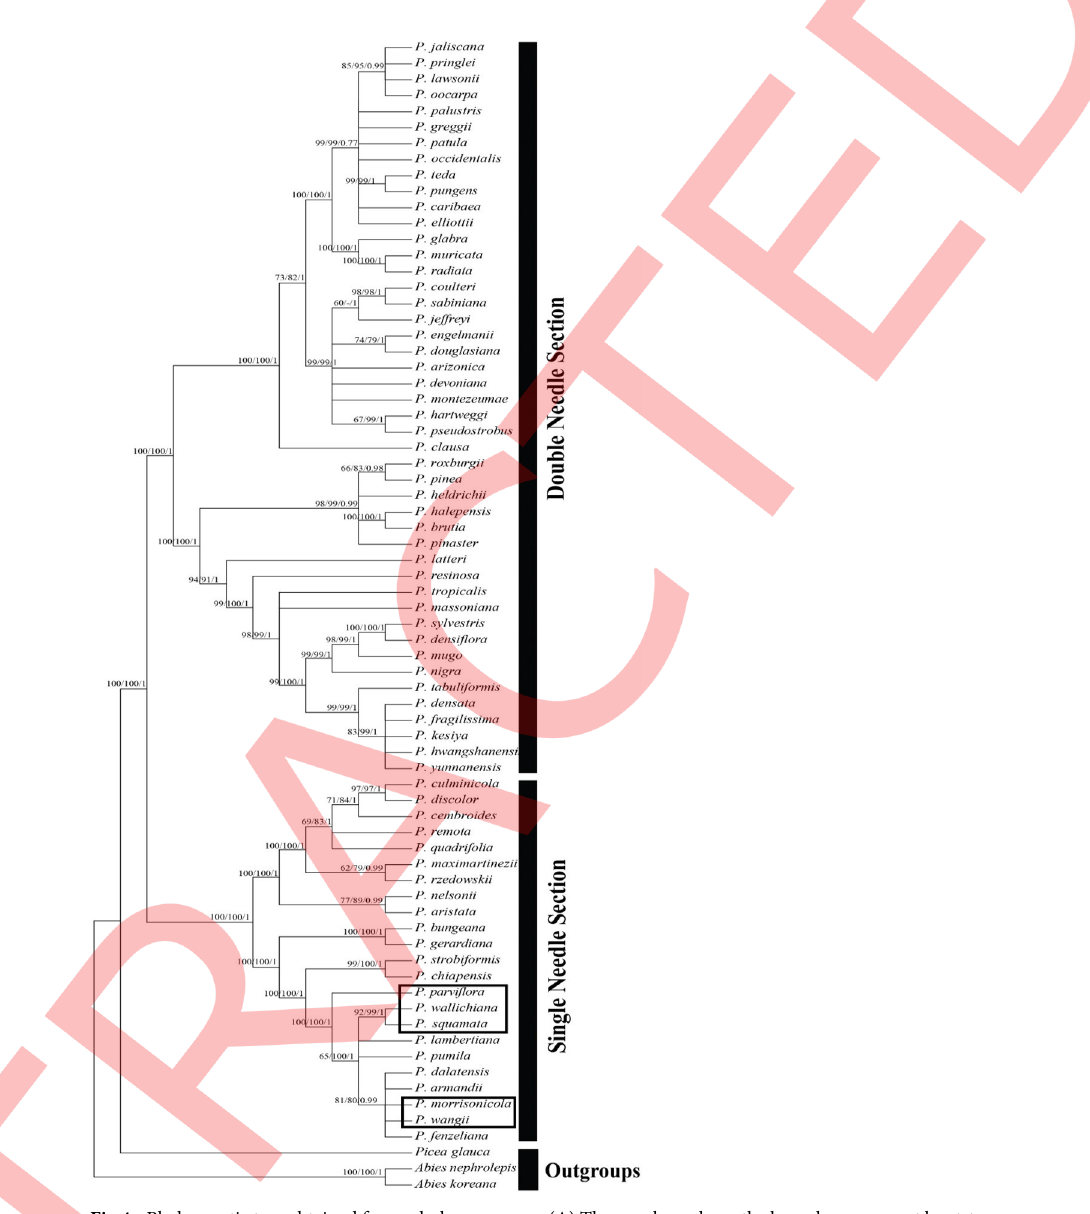
Fig 4. Phylogenetic tree obtained from whole cp genome (A) The numbers above the branches represent bootstrap values greater than 50% for ML (left) and MP (middle) analyses, and Bayesian posterior probabilities (right). A dash shows a bootstrap value less than